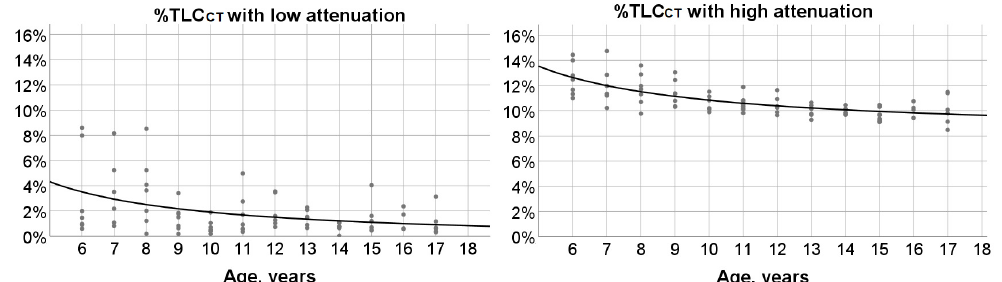
Figure 5. Left panel : Scatterplot outlining the significant, but weak association between % total lung capacity measured by computed tomography scan (TLC CT ) with low attenuation and age (r 2 = 0.17; p < 0.0001). Right panel : Scatterplot and fit hyperbola curve describing the significant relationship between %TLC CT with high attenuation and age (r 2 = 0.49; p < 0.0001). Dots correspond to measured values for individual subjects.